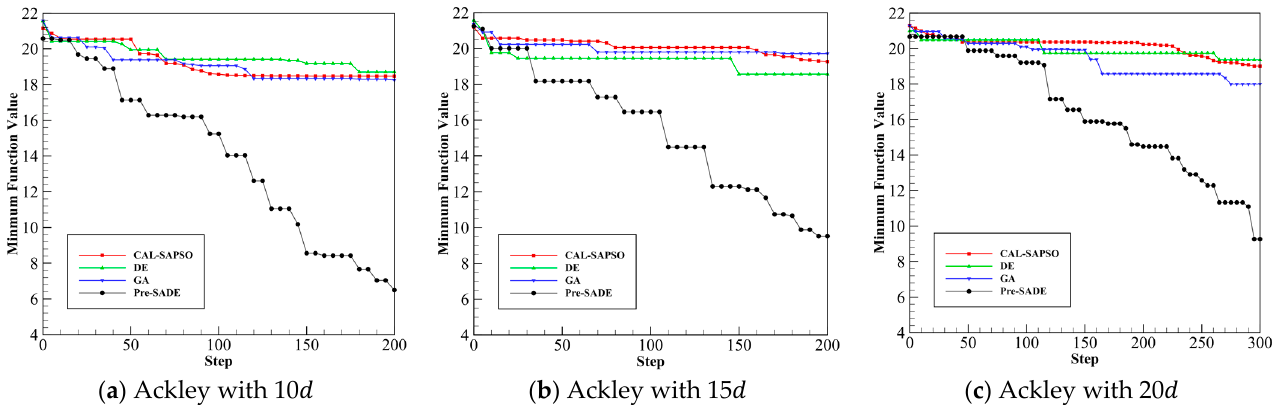
Figure 3. Convergence history of CAL-SAPSO, DE, GA, and pre-SADE on the Ackley of ( a ) 10 𝑑 , ( b ) 15 𝑑 , and ( c ) 20 𝑑 .